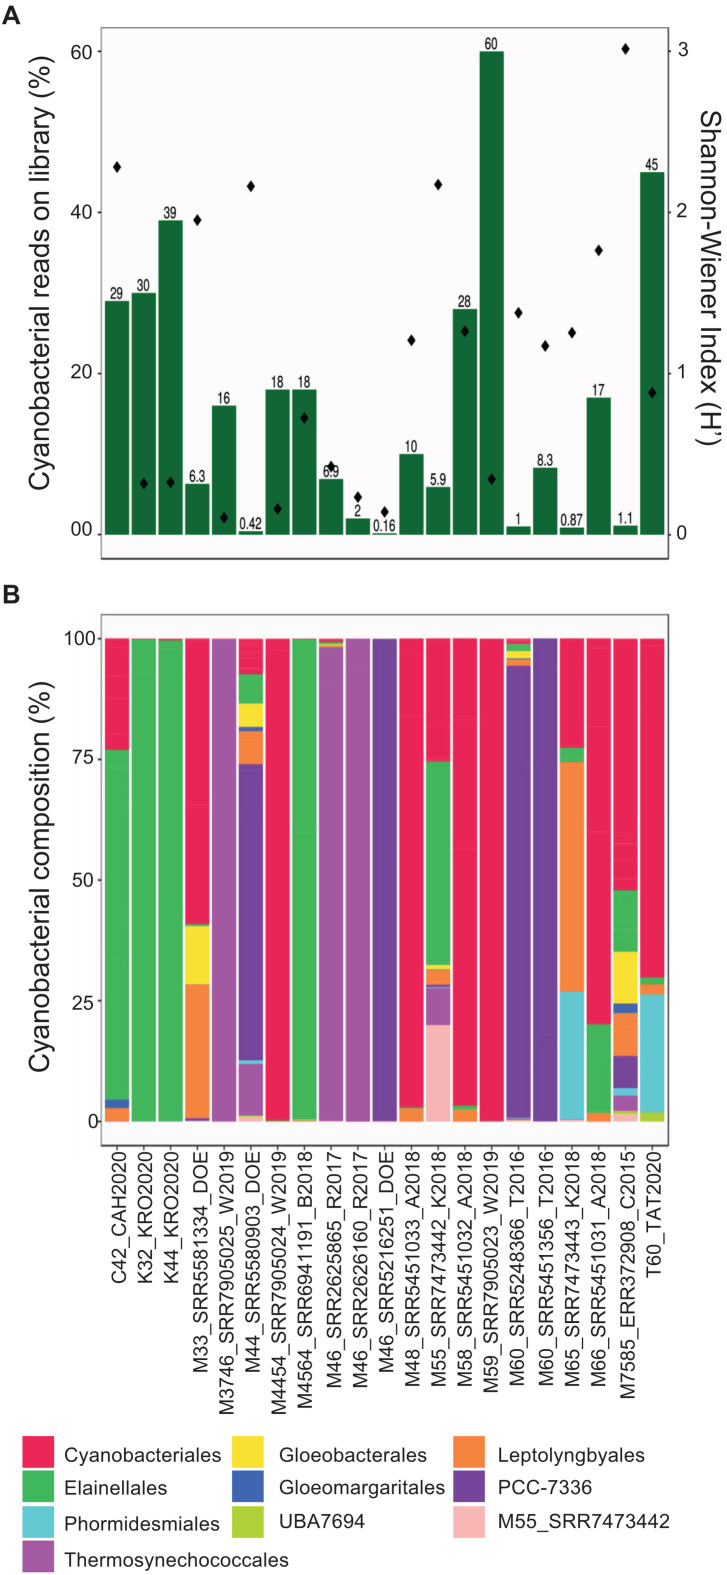
Diversity of hot spring cyanobacterial MAGs in metagenomes. (A) Left y-axis corresponds to the percentage of total mapped reads from each hot spring to a cyanobacterial MAG (green bars). Right y-axis corresponds to alpha-diversity values (dots) for each metagenome. (B) Normalized (relative) abundances of the reads assigned to each MAG at the order level in each sample. The possible new order is shown as M55_SRR7473442.